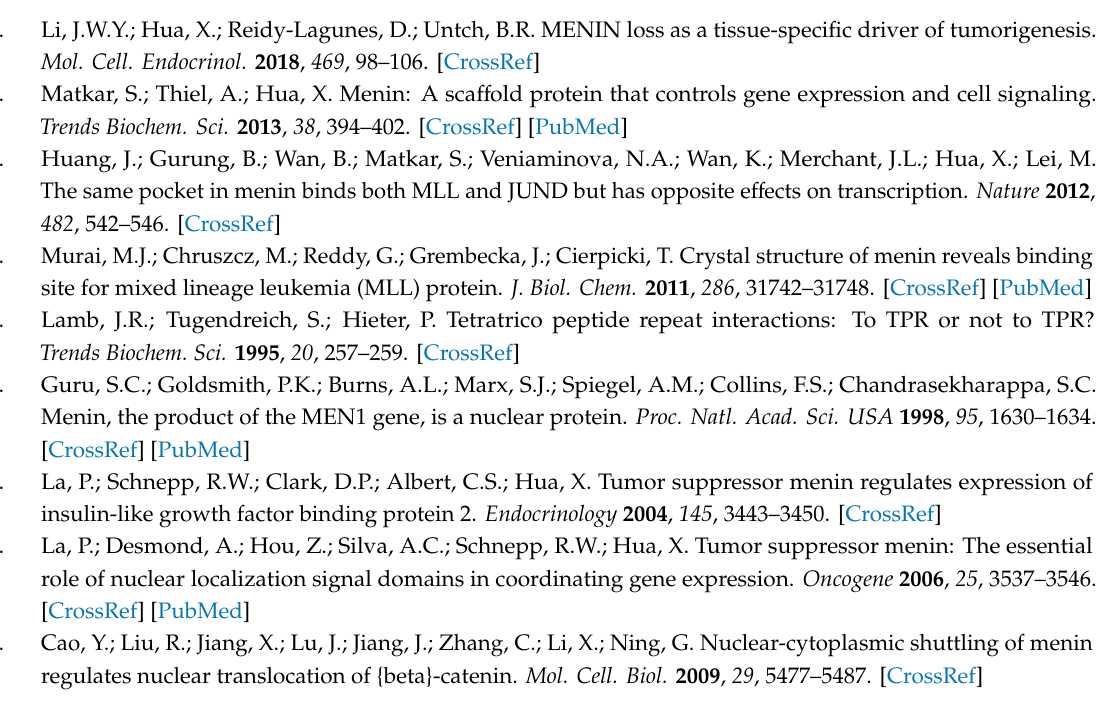
Figure S1: Amino acid sequence alignment of various MENIN isoforms, Figure S2: Example of the Kolmogorov- Smirnov uniformity test statistic, Figure S3: Distribution of ClinVar and COSMIC mutations by type, Table S1: Summary of MEN1 mutations reported on COSMIC, Table S2: ClinVar confirmed pathogenic mutations, Table S3: CRAVAT input values, Table S4: CRAVAT output non-TCGA values, Table S5: CRAVAT output TCGA